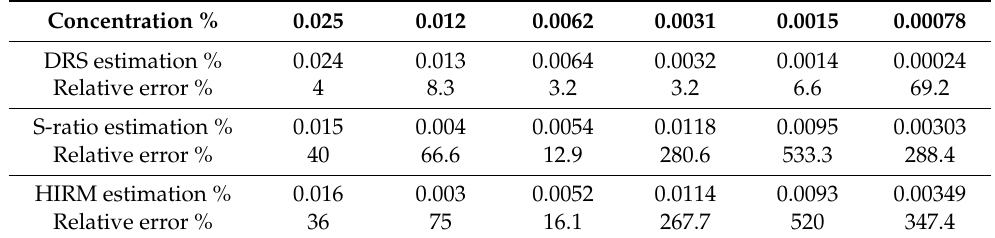
Figure 10. Comparison between DRS and magnetic methods in detecting synthetic samples with low hematite concentrations. Detection results of ( a ) DRS, ( b ) S-ratio, and ( c ) HIRM. Table 1. Comparison of the estimated hematite concentration between DRS and magnetic methods.